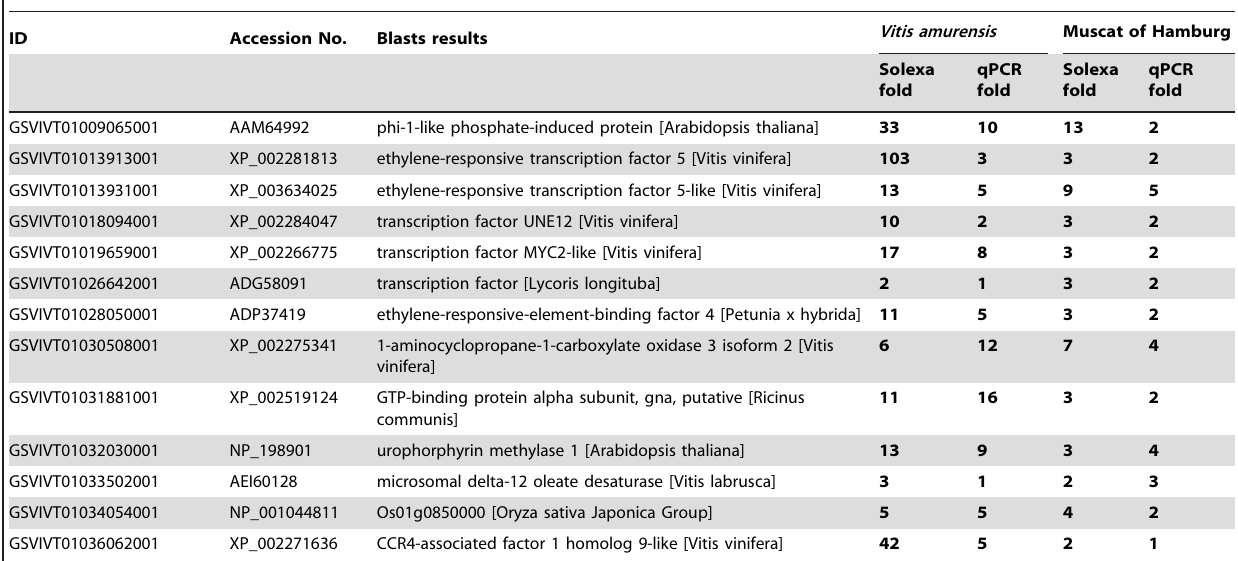
Table 7. List of genes selected for Real-time RT-PCR.